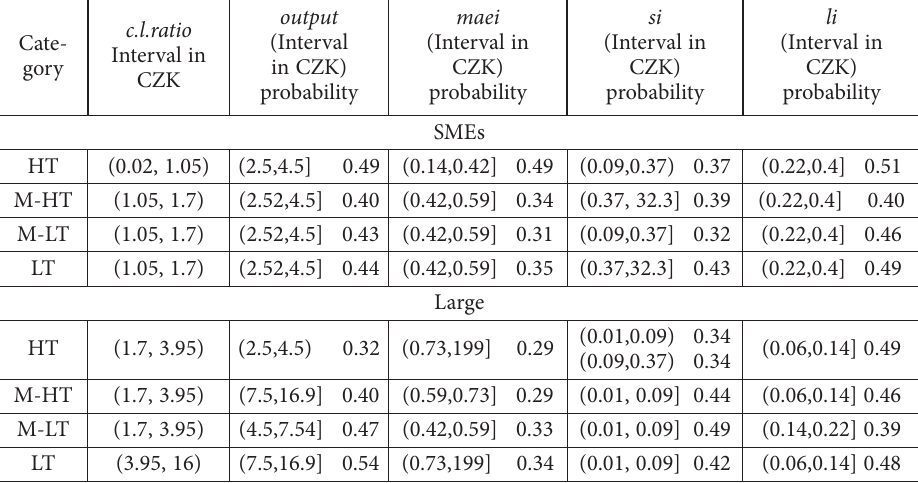
Table 3. Probabilities and interval of indicator (source: authors’ calculation) c.l.ratio Cate- Interval gory